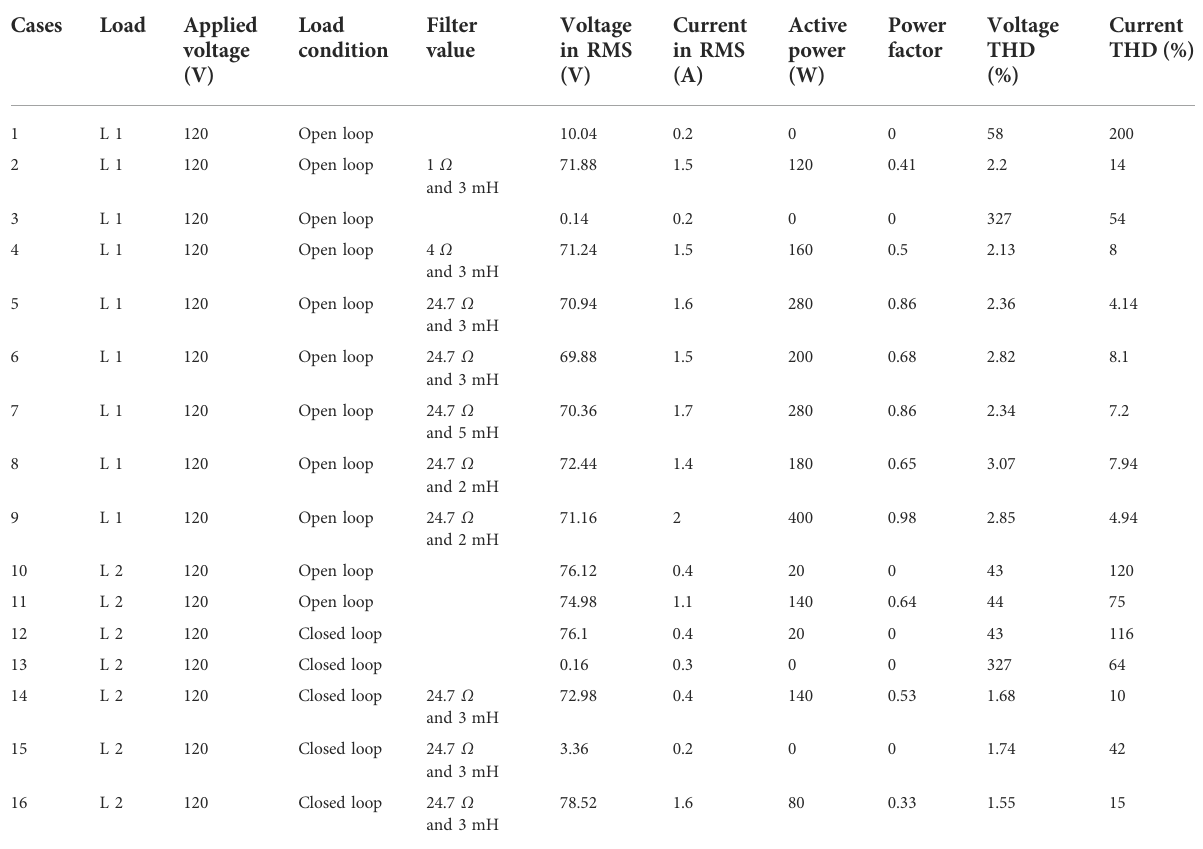
TABLE 9 Voltage and current % THD for different